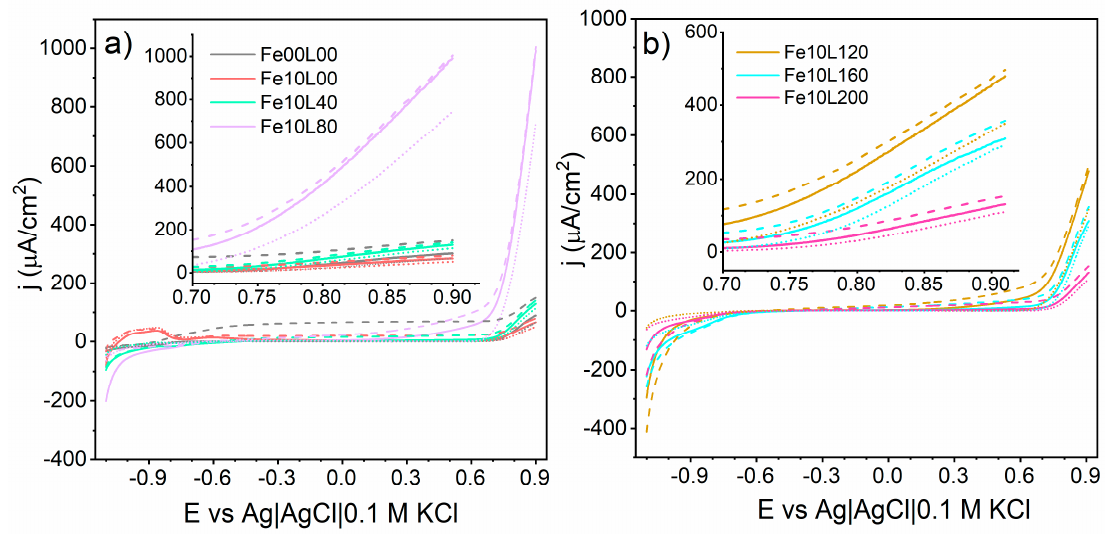
Figure 10. Records of linear voltammetry carried out in darkness (dotted), under simulated solar (dashed), and visible (solid) light for ( a ) bare titania and with Fe film further treated with 40 and 80 mJ/cm 2 and ( b ) 120,160, and 200 mJ/cm 2 . The stability of the laser-annealed Fe-decorated TiO 2 -NTs was verified